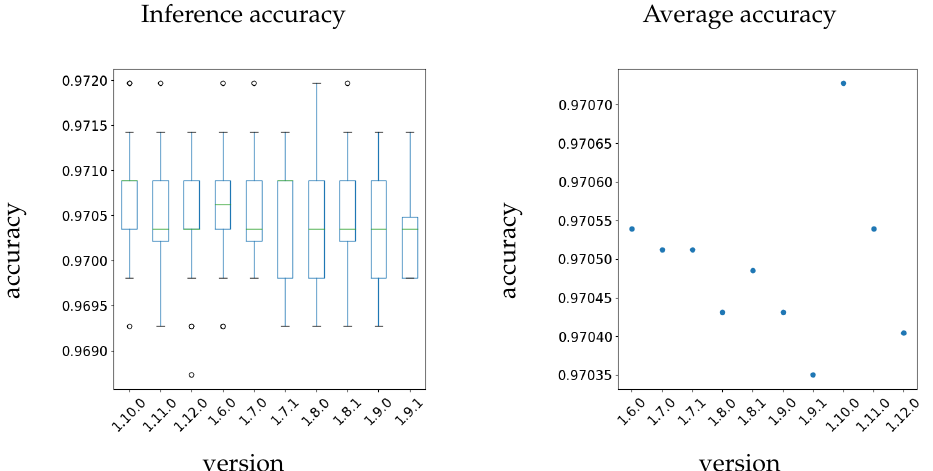
Figure 7. The results for the Pulsar dataset using Pytorch.